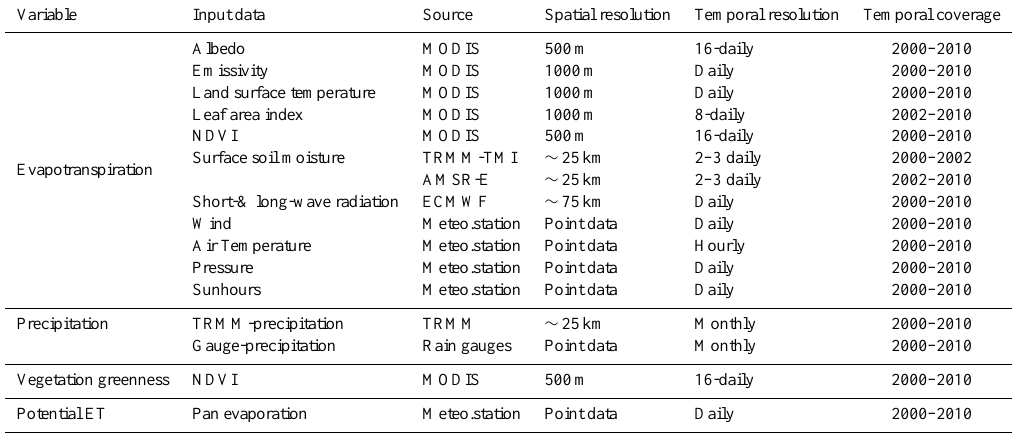
Table 1. The summary of the data used in the